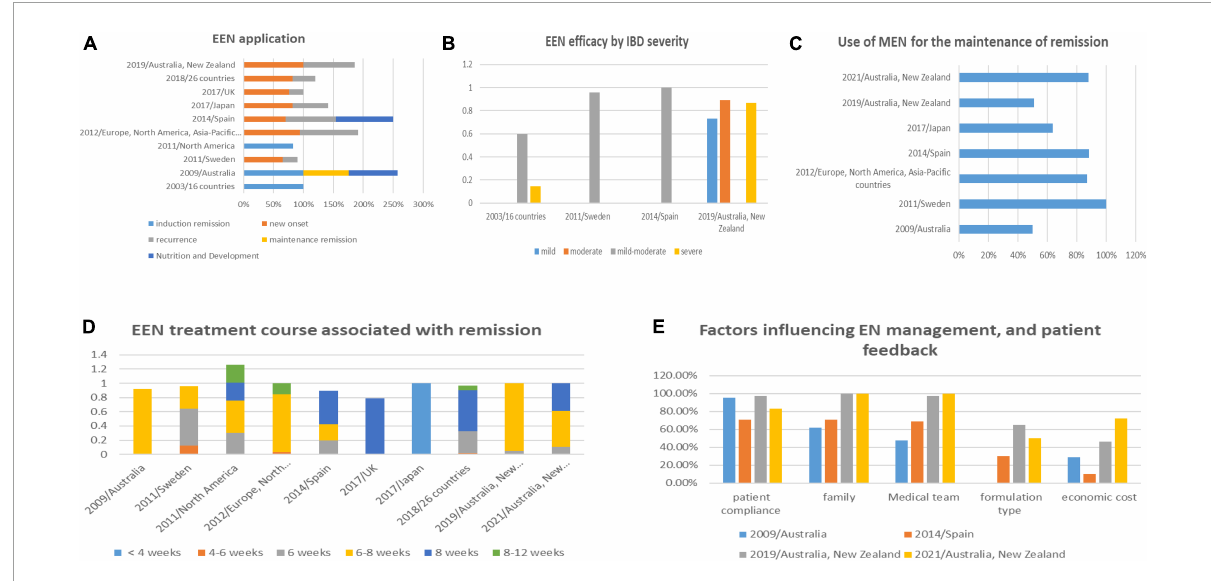
FIGURE2 Comparison of the application of EN in pediatric IBD in various